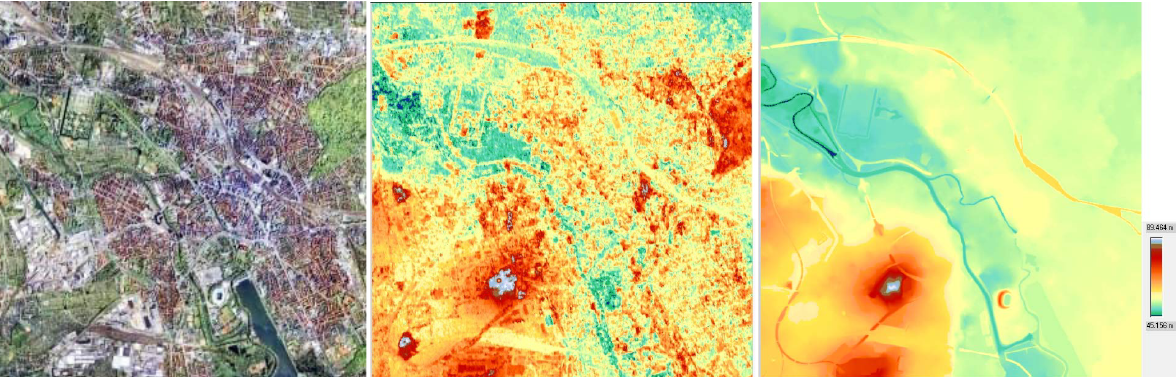
Fig. 2: Subset Inner city area of Hannover: Google image, CoSCC DSM, Reference